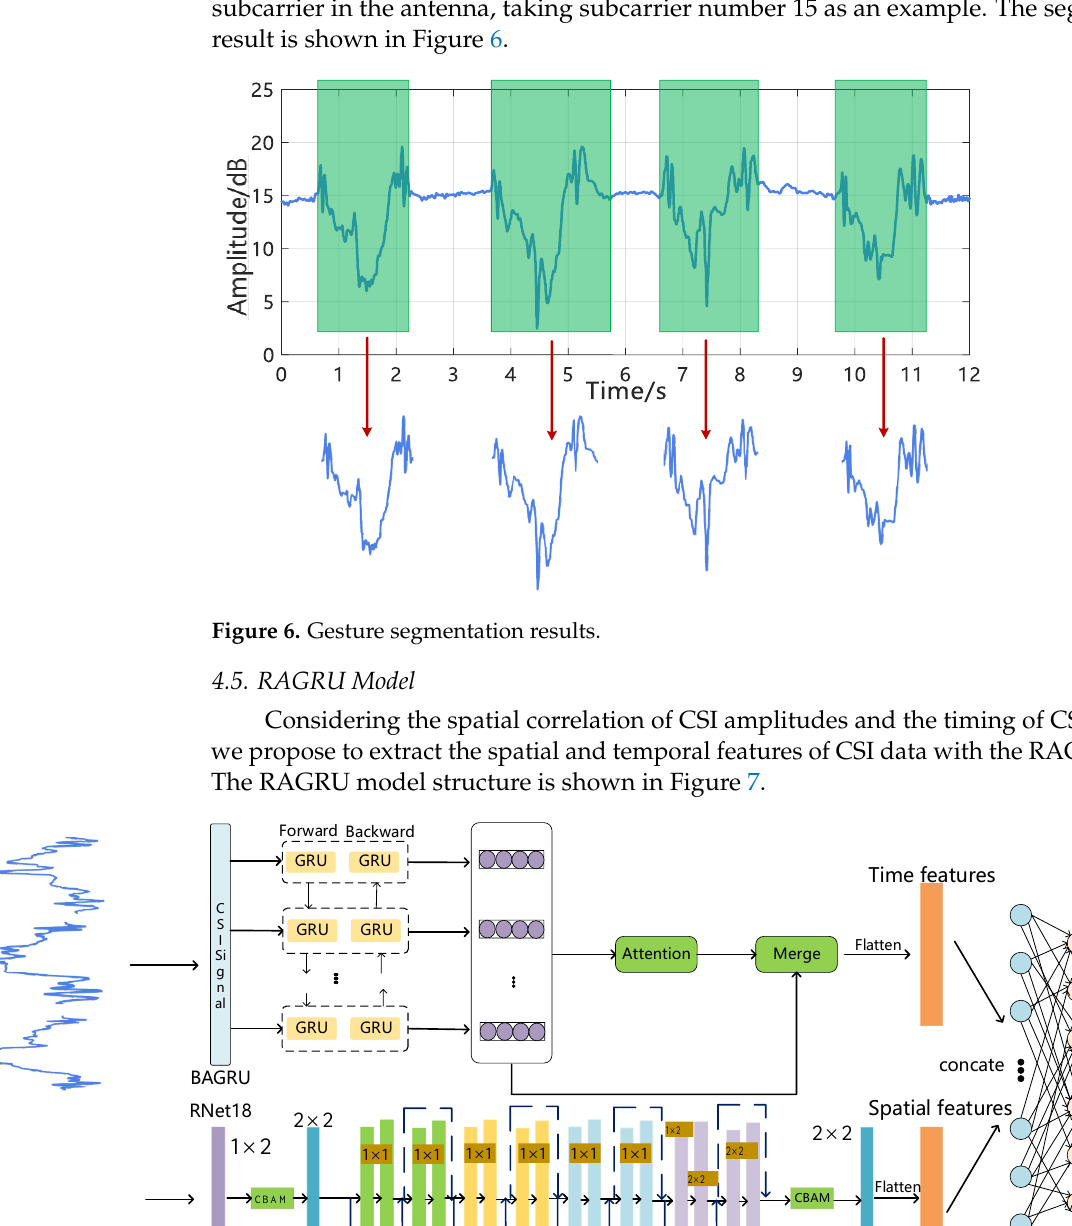
Figure 7. Flow chart of the RAGRU algorithm.